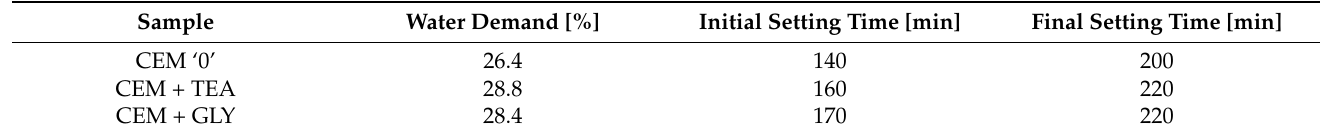
Table 5. Water demand and setting times of cements.